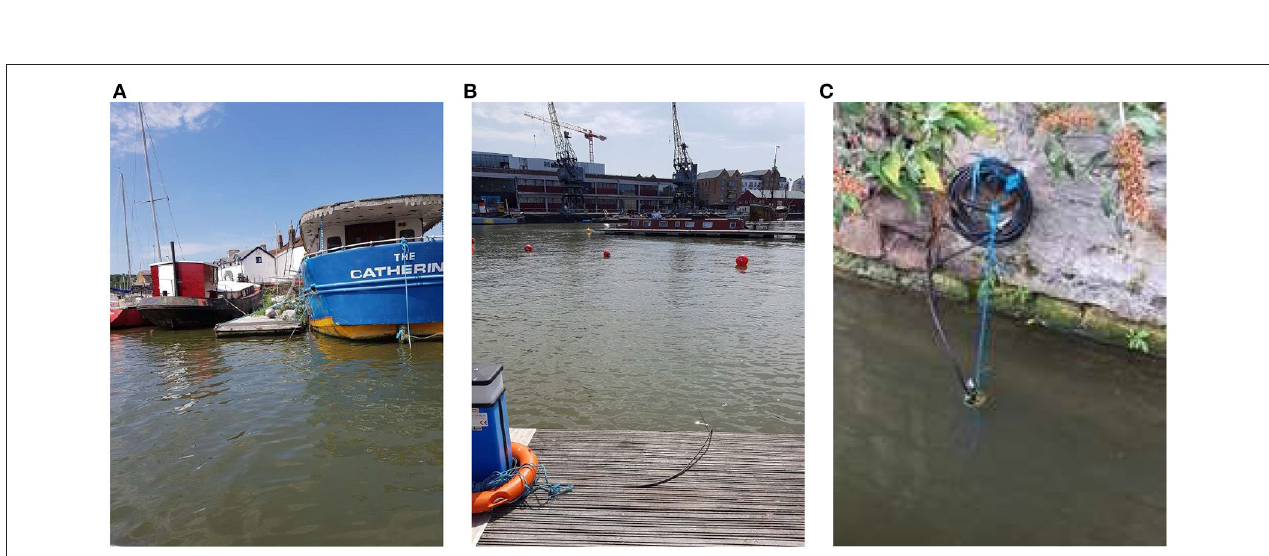
water quality monitoring networks. The following